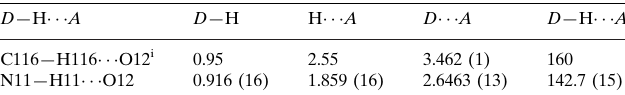
Hydrogen-bond geometry (A˚ , (cid:2) ).